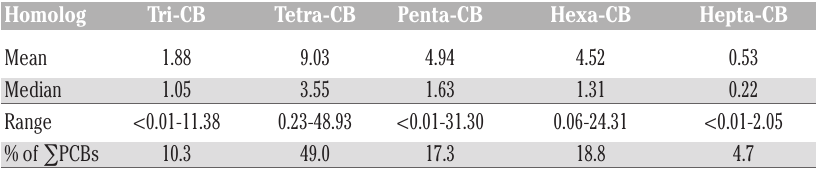
PCBs, polychlorinated